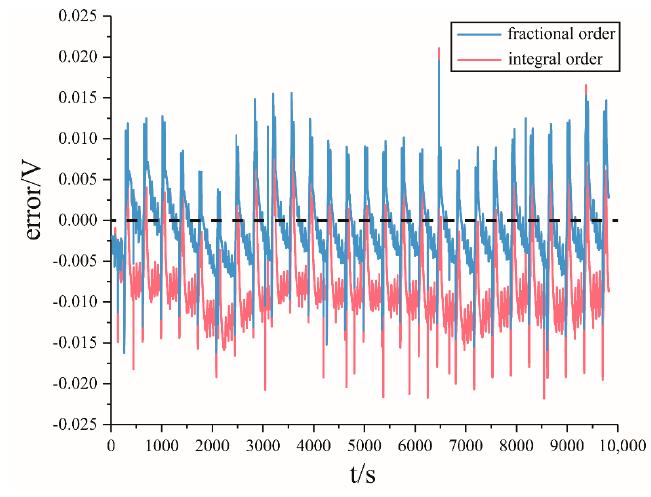
Figure 15. Comparison of terminal voltage between fractional model and integral model under 26 continuous DST conditions at 28 °C.